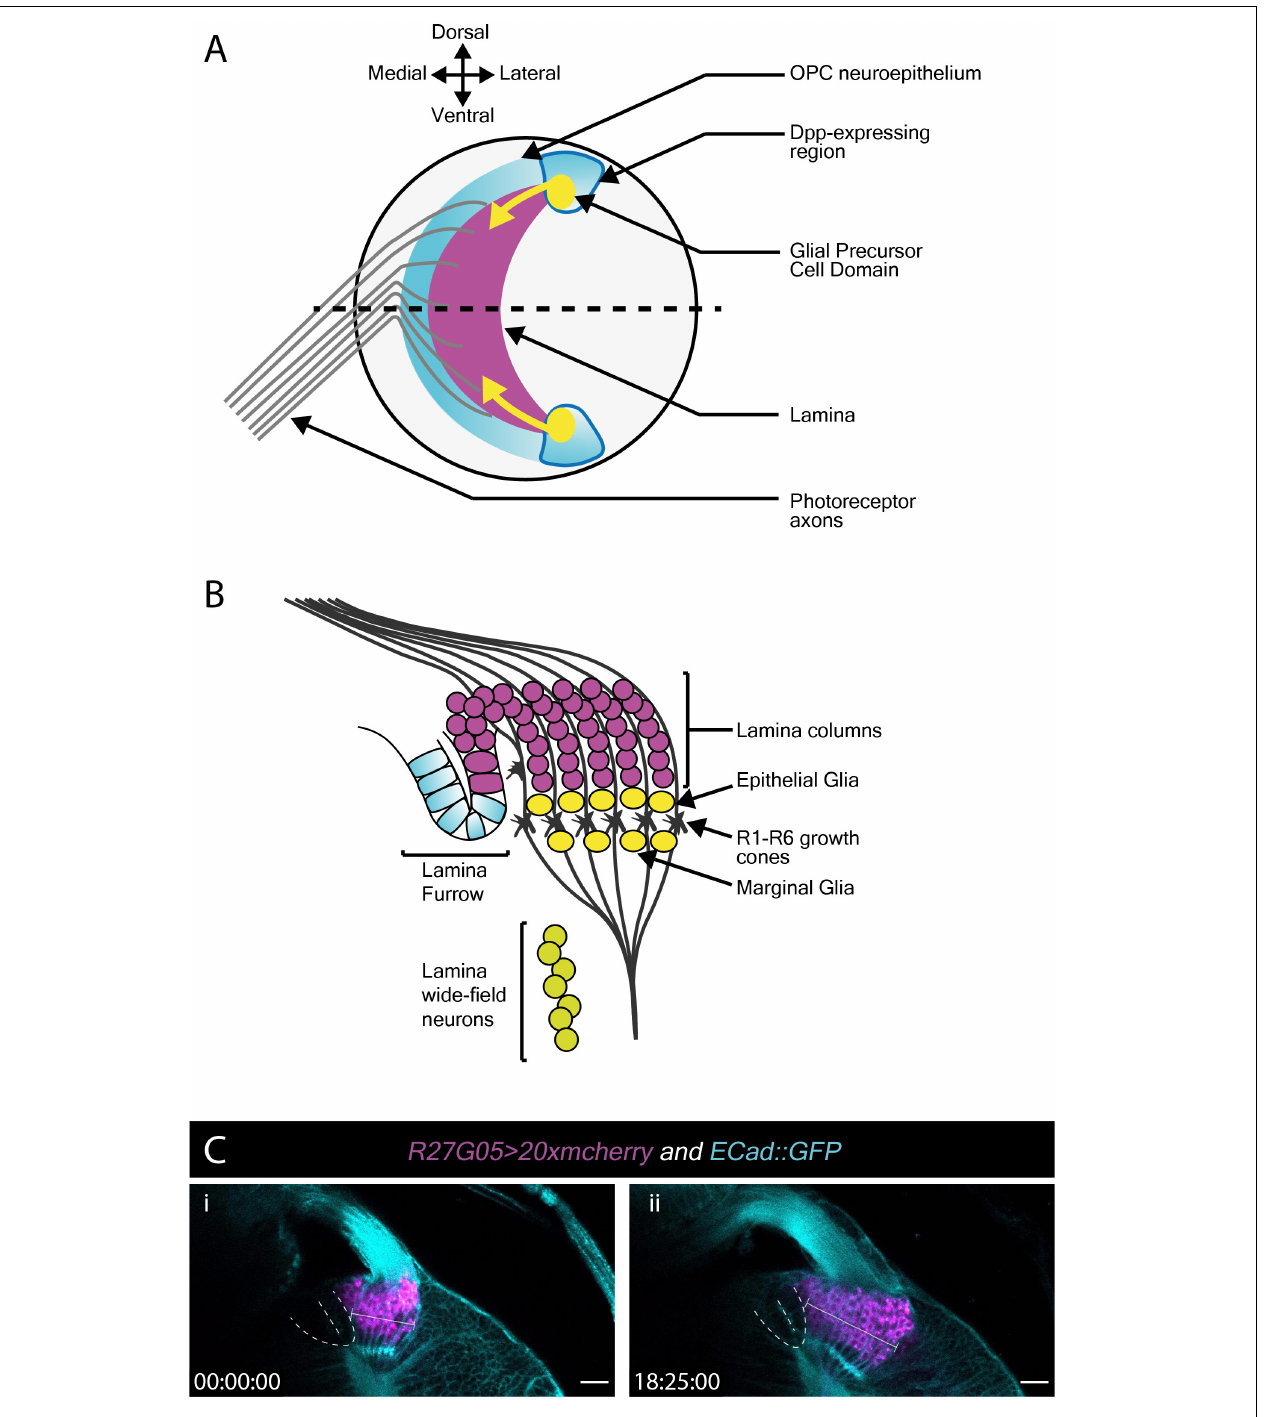
FIGURE 3 | Lamina development including the migration of epithelial and marginal glia, and lamina wide-field neurons (Lawf) . (A) Schematic of the lateral view of the third larval instar optic lobe. Developing photoreceptors project to a fold in the outer proliferation center neuroepithelium called the lamina furrow and induce lamina formation. (B) Diagram of a cross-section along the dotted line in A. The developing lamina forms in characteristic columns. Seven lamina precursor cells are incorporated into each column. Epithelial and marginal glia migrate above and below photoreceptor growth cones. Lawf neurons share the same progenitors as epithelial and marginal glia; they migrate from their point of origin at the tips of the lamina to the medulla, where they stop immediately adjacent to the neuropil. (C) Two timepoints extracted from Movie 3 of a cultured R27G05 > 20xmcherry (magenta) and Ecad::GFP (cyan) brain (wL3) showing the lamina, photoreceptor axons and surrounding tissue. The lamina furrow is marked by a dashed line. The lamina grows considerably over ∼ 18 h as indicated by the bracket. Timescale displayed as hh:mm:ss, scale bar = 20 µ m.